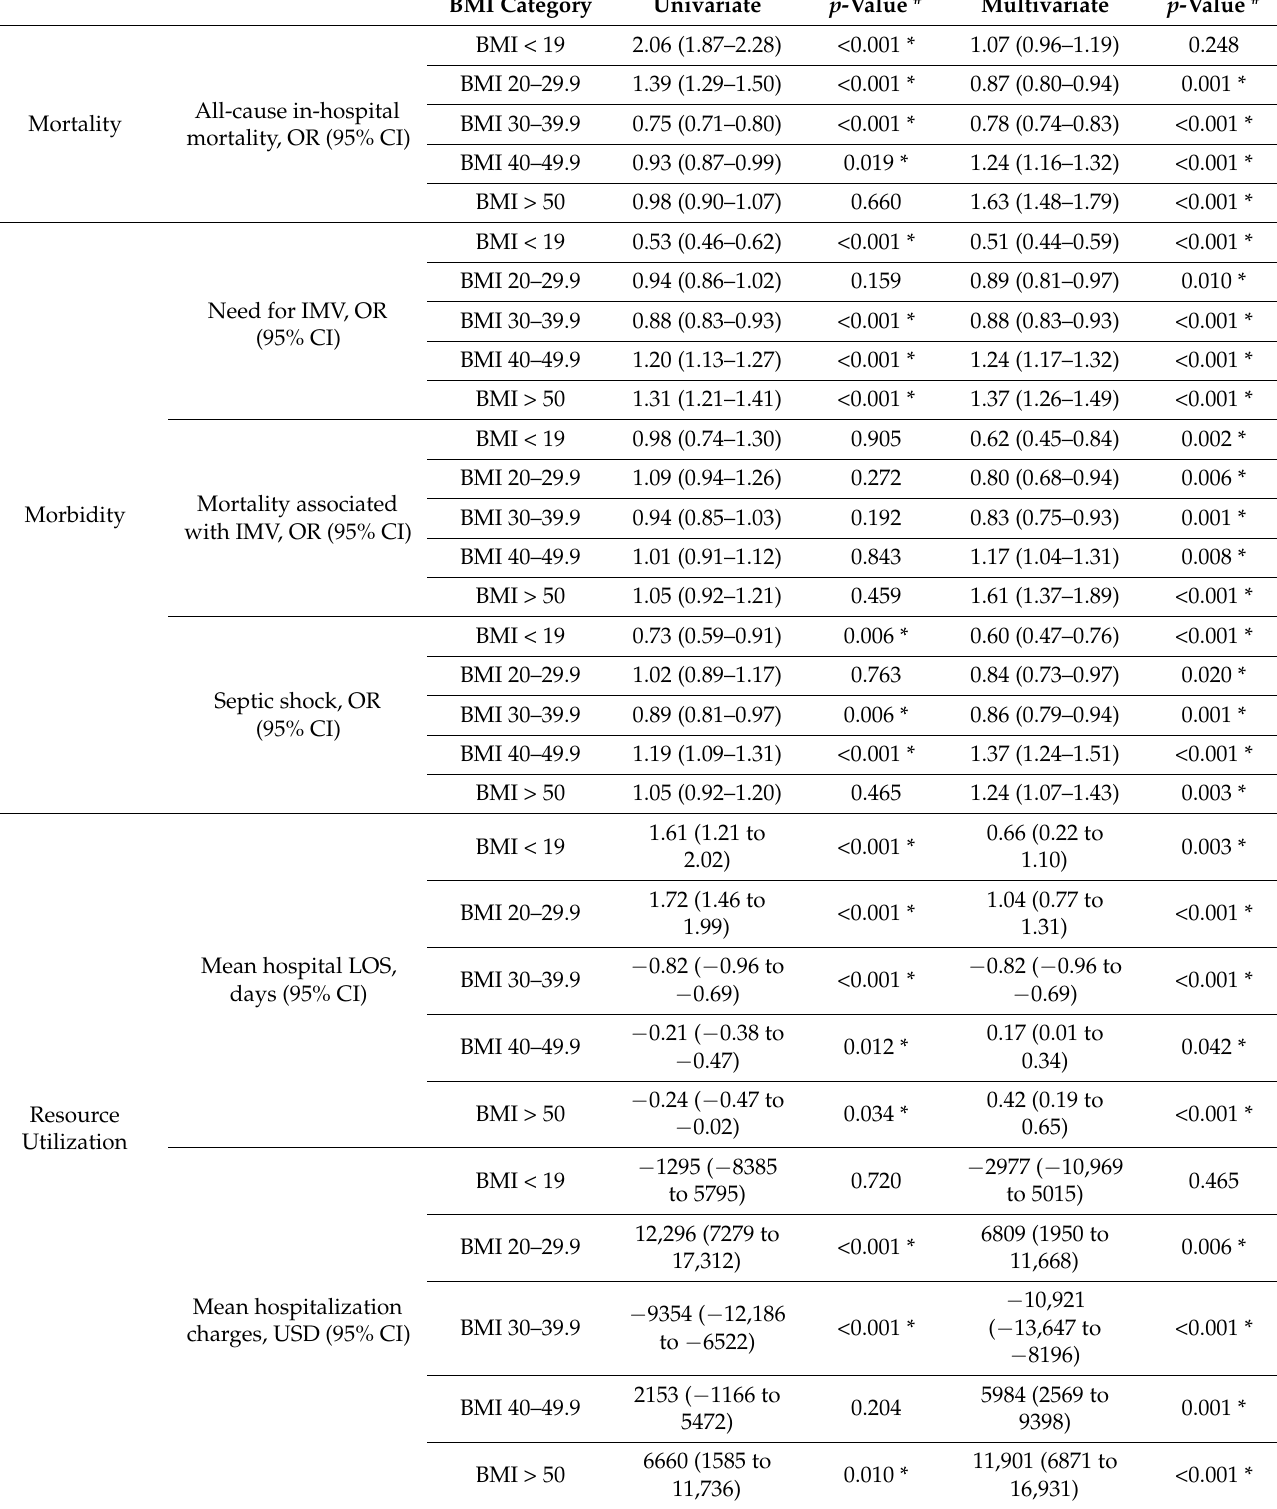
Table 4. Regression outcomes of separate body mass index